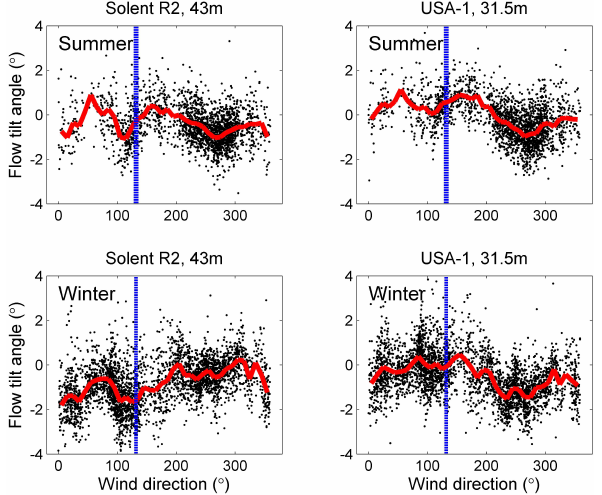
Fig. 5. Near-neutral dataset analysis of tilt angle during full leaf area index conditions (top) and low leaf area index conditions (bottom). The thick red line is the centered bin averages for each 10 ◦ interval and the black dots correspond to the 30min mean values. The vertical dashed line indicates the direction of the mast from the boom at 130 ◦